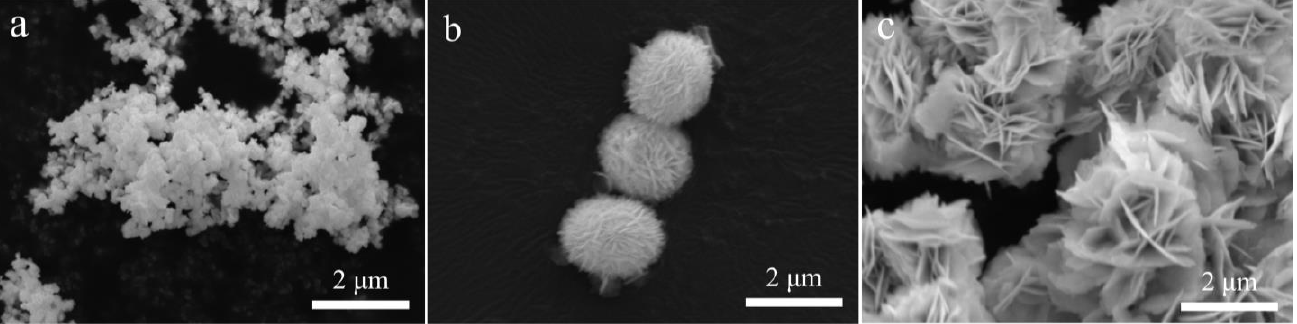
Figure 2. SEM images of ( a ) BiOF, ( b ) BiOBr and ( c ) BiOI.